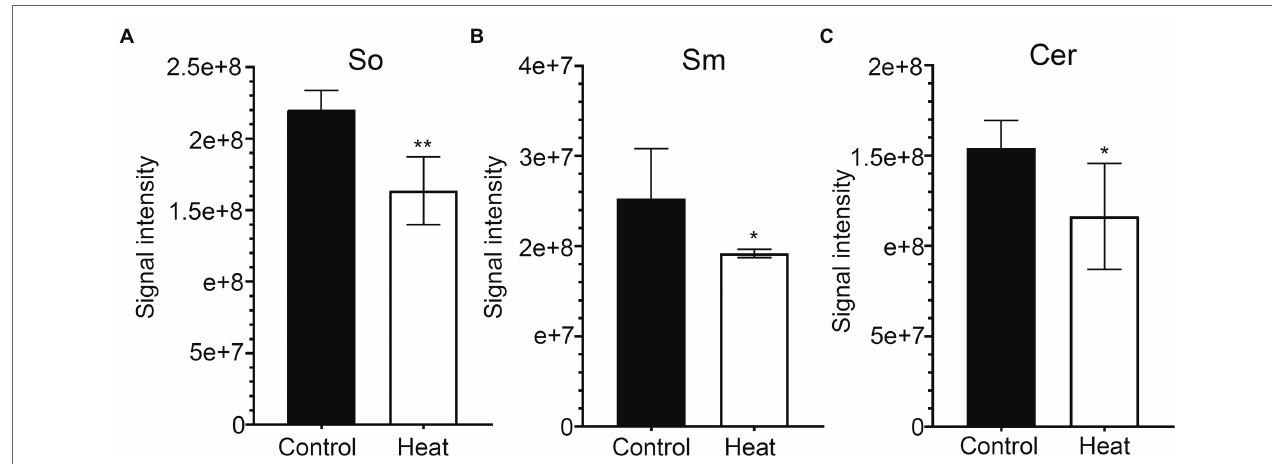
FIGURE 8 | Changes in the levels of sphingolipid molecular species in response to heat stress. Fully extended leaves detached from 173-d-old plants of B. grandis were at control condition (22 ° C for 2 h) or challenged with heat stress (45 ° C for 2 h). (A) So, sphingosine; (B) Sm, sphingomyelin; (C) Cer, Ceramides. Values shown are mean ± SD ( n = 5). * p < 0.05, ** p < 0.01, two-sided Student’s t-